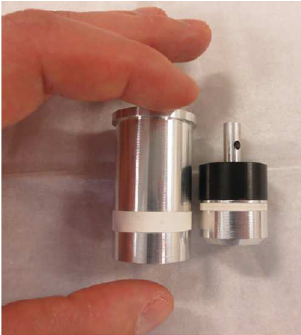
Fig. 5. Linear self-shielded reactivity modulator in ZED-2 reactor: a piston (right) and sleeve (left) coupling [15].